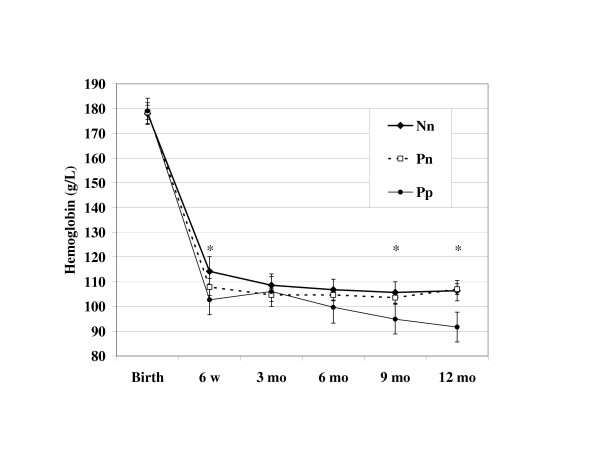
Hemoglobin concentration during the first year of life in Zimbabwean babies by HIV status. Values are means with 95% confidence intervals, adjusted for birthweight. The asterisk indicates a statistically significant difference in mean hemoglobin among the groups at a certain time point (6 weeks, F = 3.54, P = 0.030; 9 months, F = 4.37, P = 0.005; 12 months, F = 11.34, P < 0.001). Abbreviations: Nn, mother HIV negative, baby HIV negative; Pn, mother HIV positive, baby HIV negative at 6 months; Pp, mother HIV positive, baby HIV positive at 6 weeks.